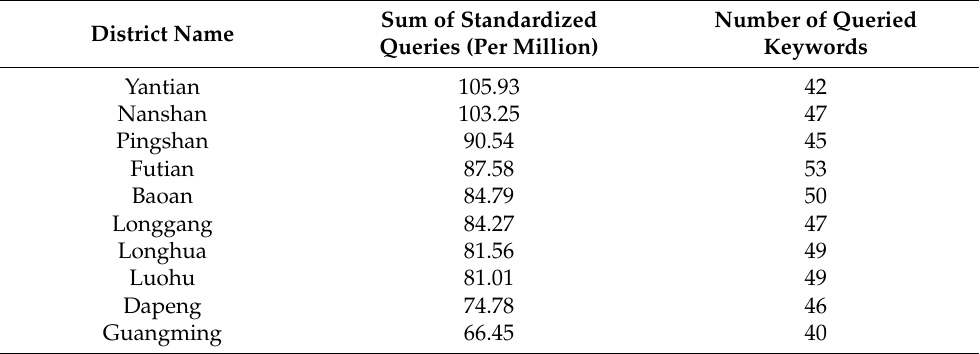
Table 2. Summary statistics of the internet search queries on the keywords at the district level.